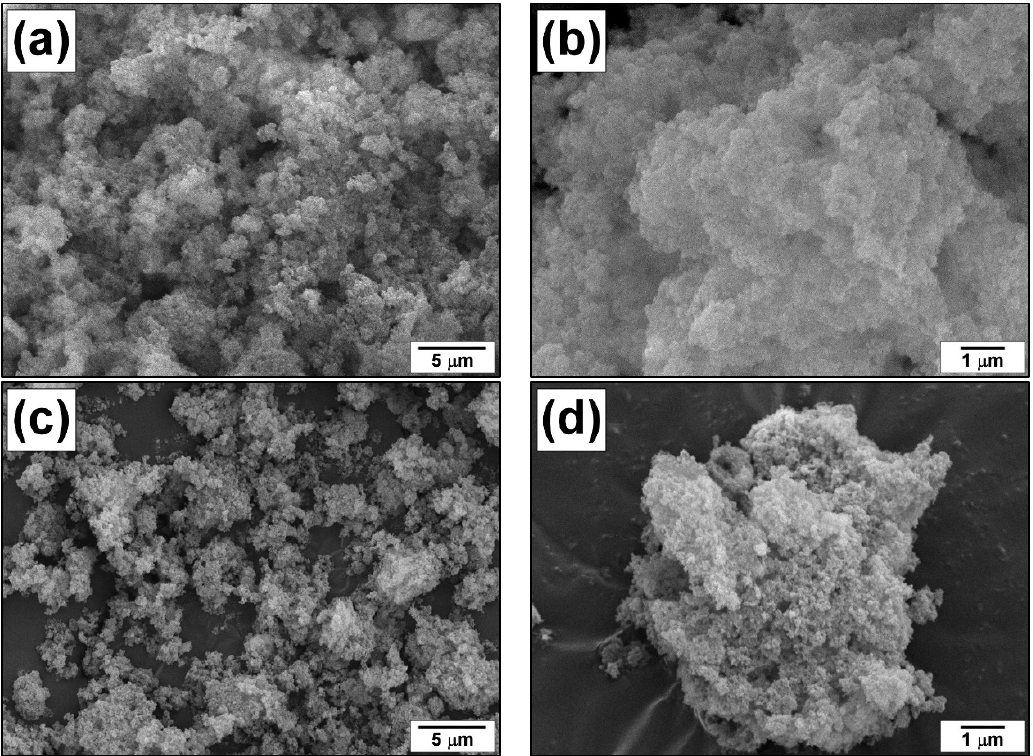
Figure 2. SEM images of the prepared samples: Cu-Mg-OH xerogel ( a , b ); Cu-Mg-O oxide ( c , d ). The low-temperature nitrogen adsorption studies have revealed the changes in the porous structure that occurred during the calcination procedure. The nitrogen adsorp- tion/desorption isotherms for the xerogel and oxide samples are presented in Figure 3a. Despite both the isotherms being characterized by the presence of a hysteresis loop, their shapes are significantly different. The quantitative parameters calculated from these re- sults are summarized in Table 1. As seen, the SSA value drops down from 410 to 120 m 2 /g, i.e., more than three times, while the decrease in pore volume is not so crucial. An increase in the average pore size from 12 to 33 nm is connected with the shift of the maximum in pore size distribution towards larger sizes and the disappearance of the small pores (Fig- ure 3b). It should be mentioned that the introduction of copper species inside the MgO matrix significantly worsens the textural properties of the latter. Thus, for pure MgO pre- pared via the same procedures with hydrolysis by distilled water instead of an aqueous solution of salt, the SSA value was as high as 243 m 2 /g [59].